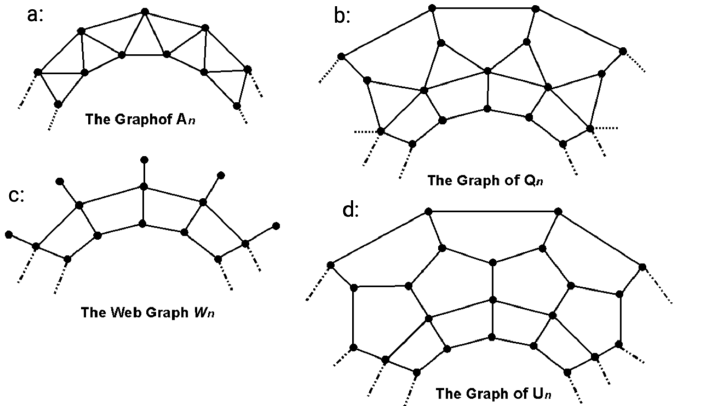
Figure 11. ( a ) The graph of convex polytope A n . ( b ) The graph of convex polytope Q n . ( c ) The web graph W n . ( d ) The graph of convex polytope U n